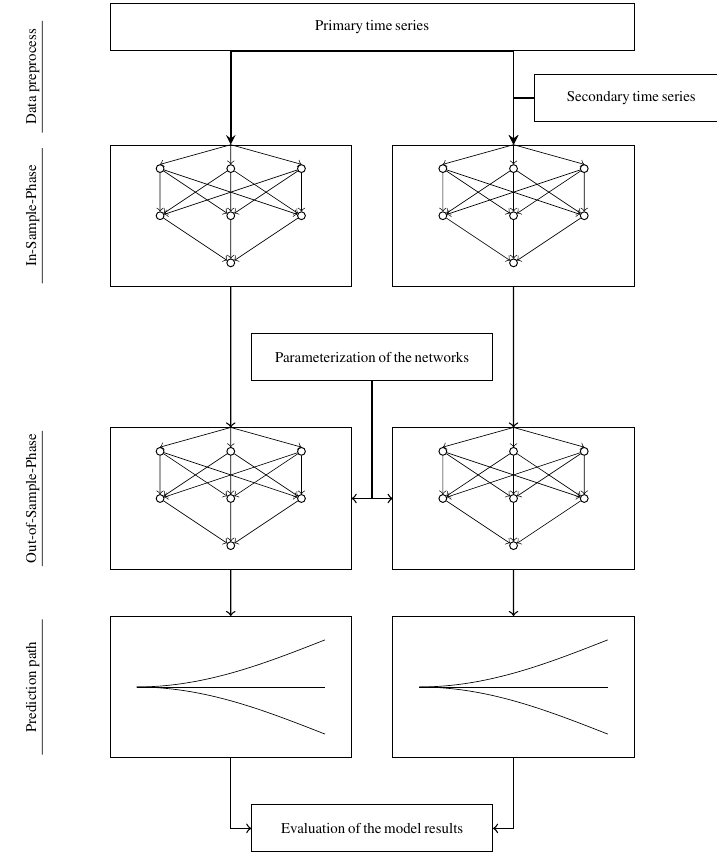
Figure 1. Our Prediction Comparison